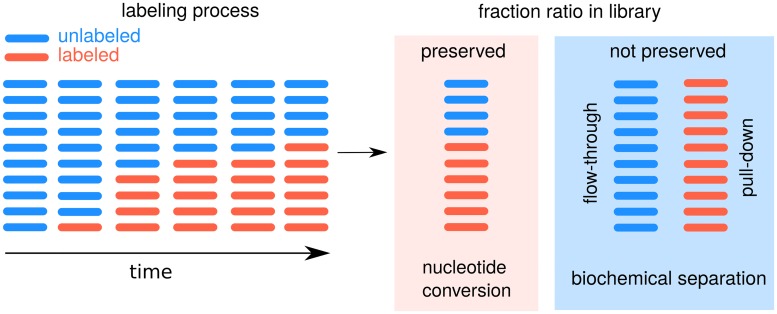
Pulse labeling experiment types to measure degradation rates.The conventional approach as in [18] utilizes biochemical separation, which does not preserve the fraction ratio (labeled vs. unlabeled) in the read counts. Alternative novel approaches (e.g. [12]) induce reverse transcription signature events (nucleotide conversions, typically T-to-C). Individual reads can be classified by the presence or absence of this characteristic nucleotide conversions. In an ideal case, the fraction ratio is well reflected by the read counts, however in practice a relatively low 4sU incorporation rate of 1:40 has to be taken into account ([12], [9]).